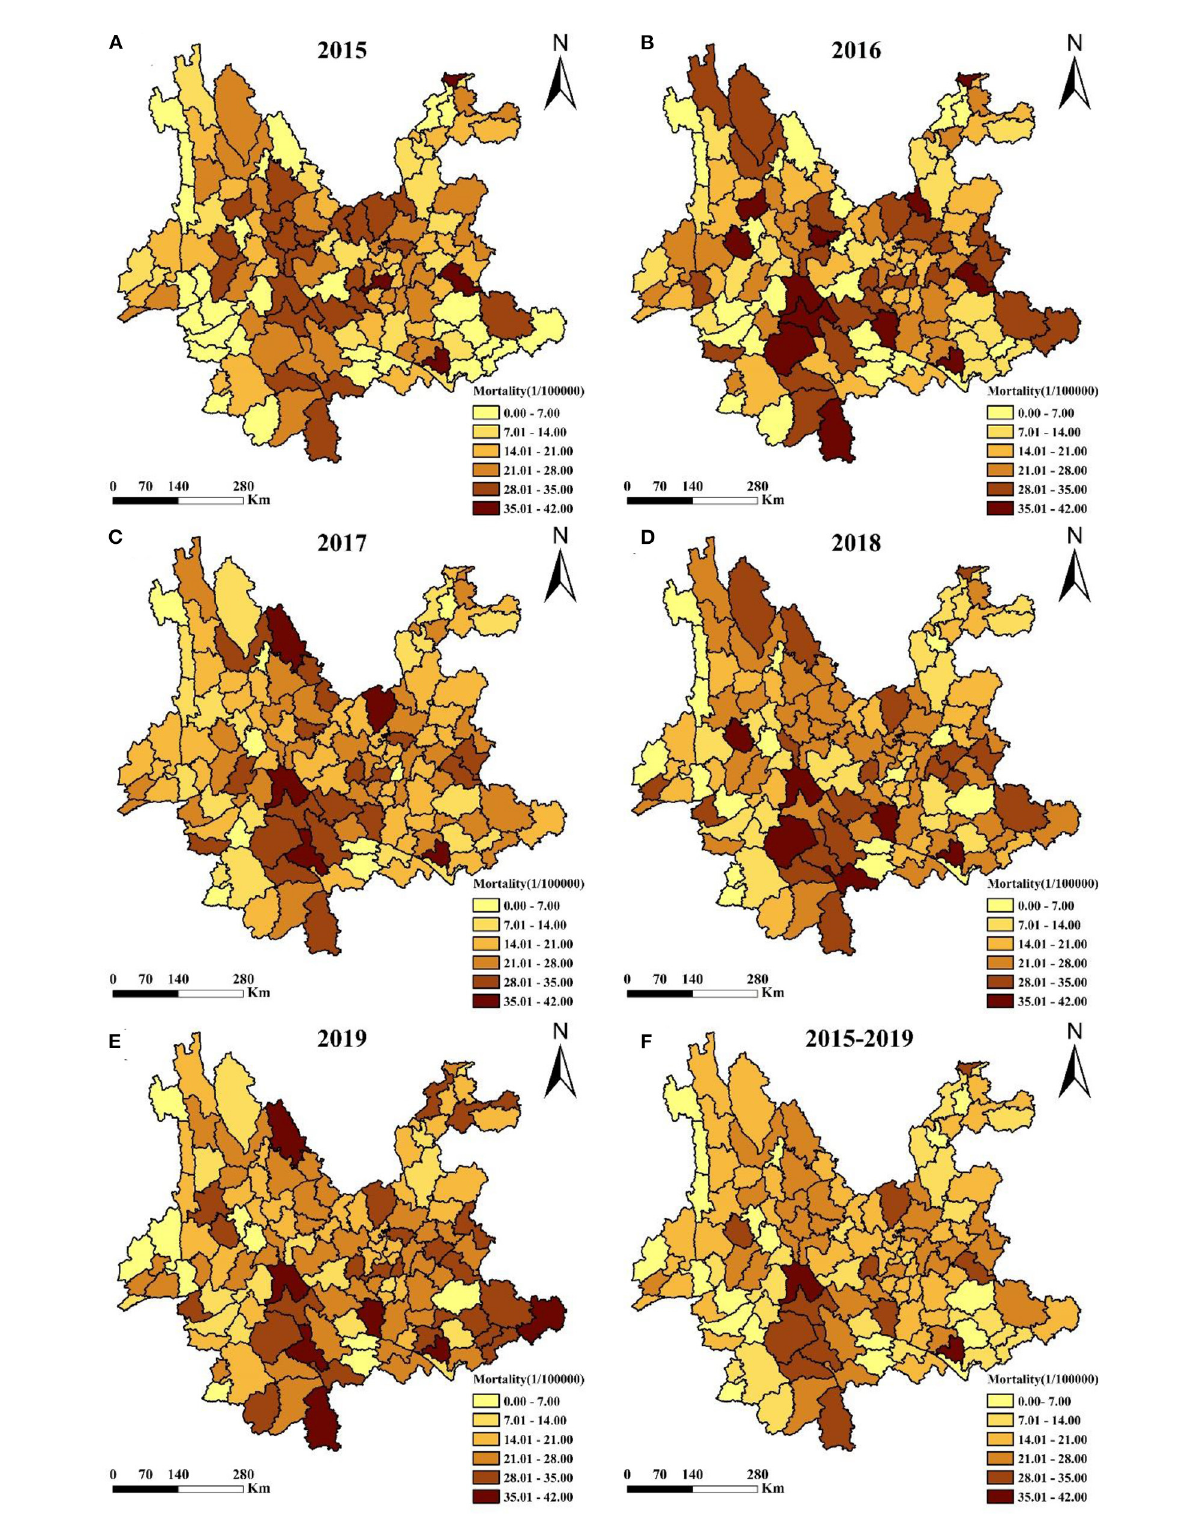
FIGURE3 Geographic distribution of liver cancer mortality rates at county level in Yunnan, 2015–2019. (A–E) year 2015–2019, (F) year 2015–2019 on average.